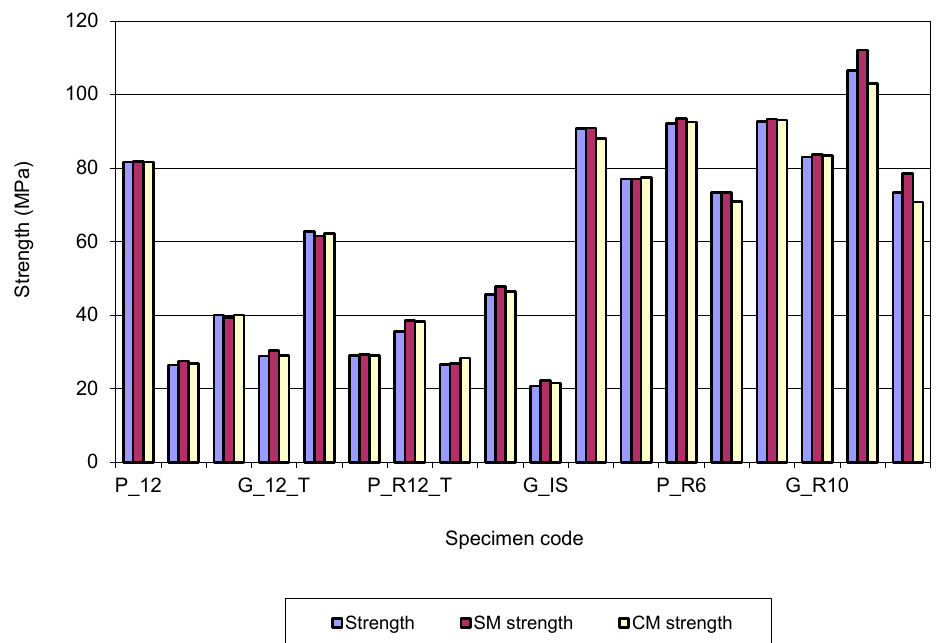
Figure 5. Evolution of the bending strength values for 3D printed specimens. In other words, the results obtained by simulation for the Von Mises stresses based on the complex schematization are closer to the tests than those obtained based on the simple schematization. The study of Table 2 and Figure 5 shows that the bar-type spec- imens have the greatest values for the strengths. Regarding the efficiency of the material consumption, the most favourable results for the strength are for the tube-type specimens or I-section. For the bar-type specimens with the rectangular cross section, the strength has great values for those with the slender cross section (height greater than width). Figure 6 shows the simulation of deformations (deflexion) for specimens having the rectangular cross section and dimensions of 5 × 10 mm. The figures show that, in the case of complex modelling, the deformations determined by simulation have lower values than those determined in tests. Furthermore, the analysis of Figure 6 shows that the values of the deformations determined by simulation based on complex modelling are lower than those determined based on simple modelling. If the application of simulation in the case of Von Mises stresses leads to results close to those determined in tests, the same cannot be said for deformations. Although the complex modelling ensures a good replication (reproduction) of the bending behaviour, the application of the simulation process for deformations is not error-free. The analysis of Figure 7 shows that for bar specimens with a circular or rectangular cross section of bar or tube type, the deformations do not have high values and the differences between the values obtained in tests and those in simulation are not significant.